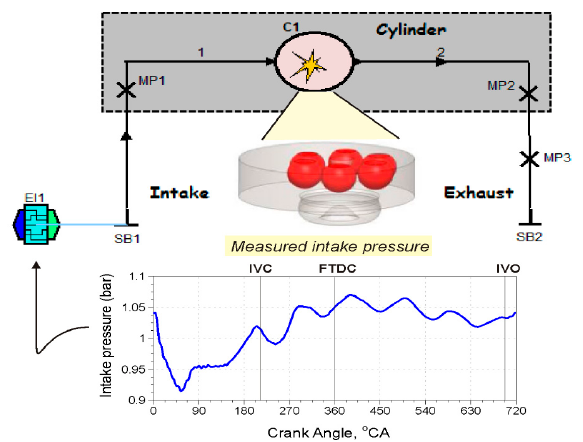
Figure 4. Reduced 1D/0D simulation model of experimental engine.